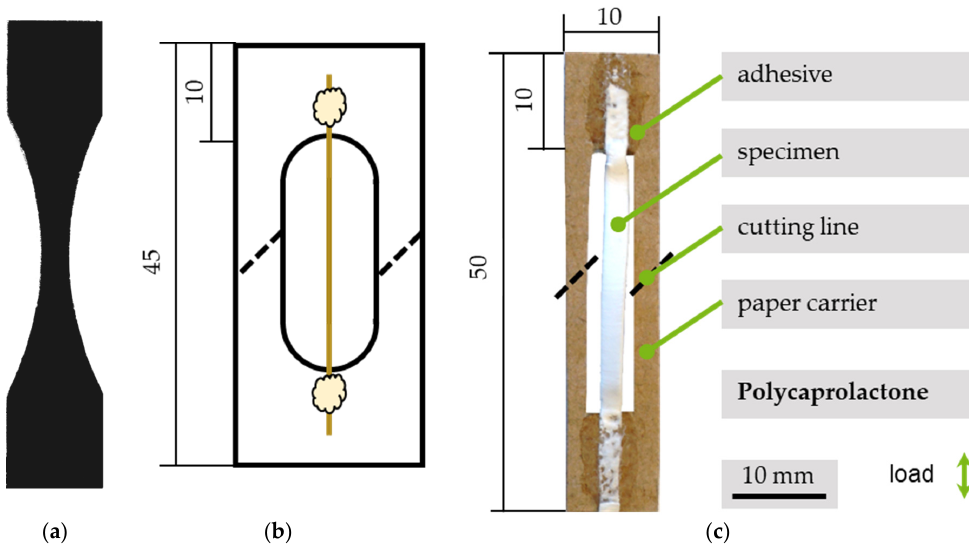
Figure 3. Ideal sample geometry for the in situ device as a basic condition for sample development ( a ). Standardized sample geometry for testing single carbon filaments according to ISO 11566 as a basis for scaffold attachment ( b ) and the resulting geometry for testing PCL fiber samples with in situ SEM methodology ( c ).